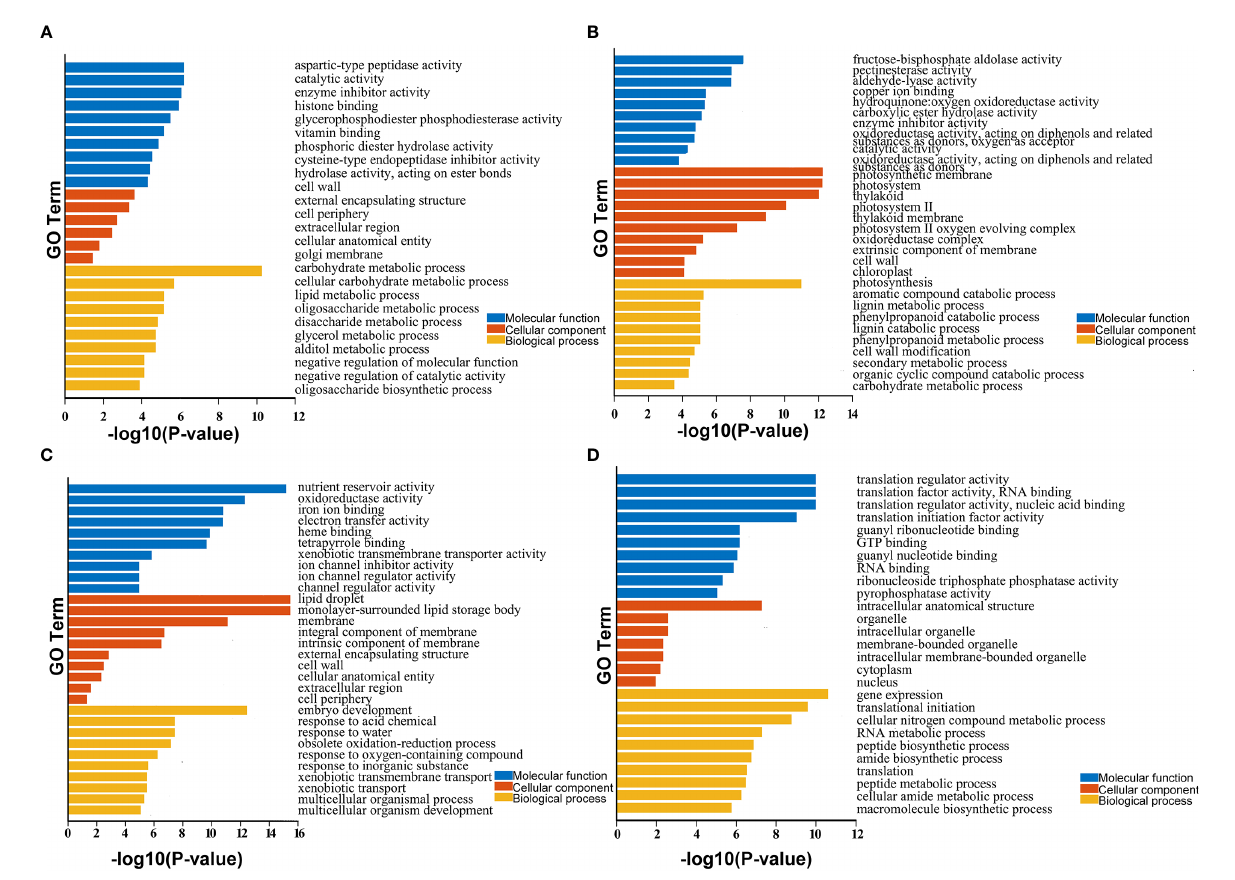
FIGURE 3 GO enrichment analysis of identi fi ed DEGs and core genes in developing seeds. (A – D) show enriched GO terms in seeds at 15, 30, and 50 DAP and 438 core genes with stable, high expression levels during seed development. Only signi fi cant categories (top 10 sorted by P-value in MF, CC, and BP) are